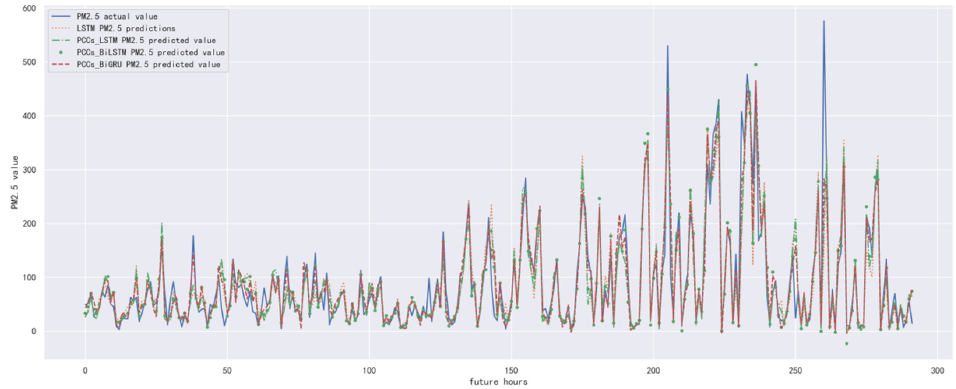
Figure 11. The schematic diagram of predicted PM 2.5 concentration in the next two hours.